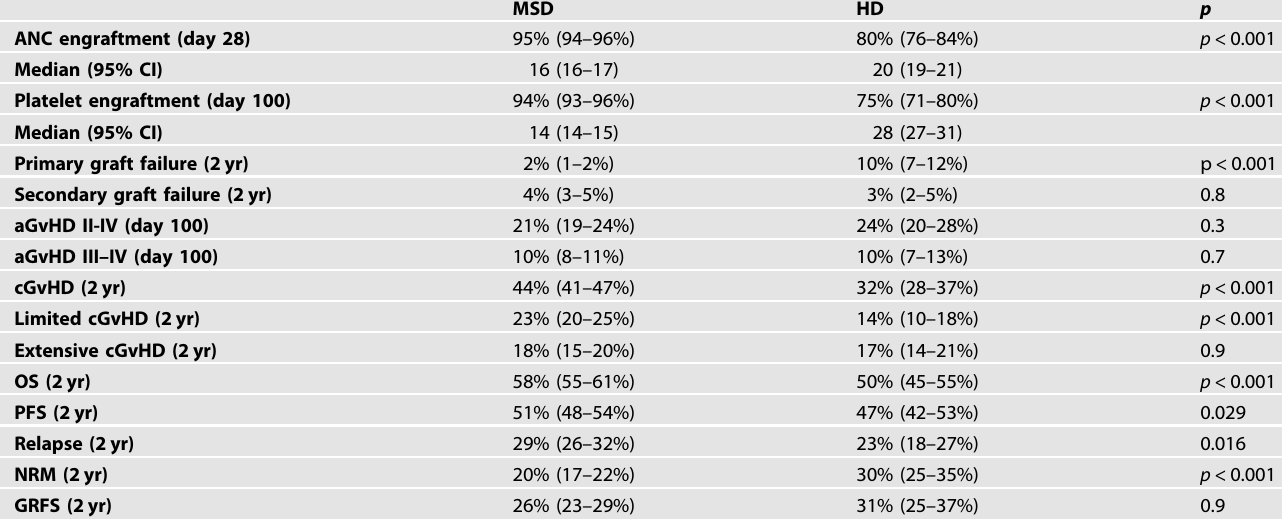
Table 2. Outcomes as per donor source in univariate analysis.